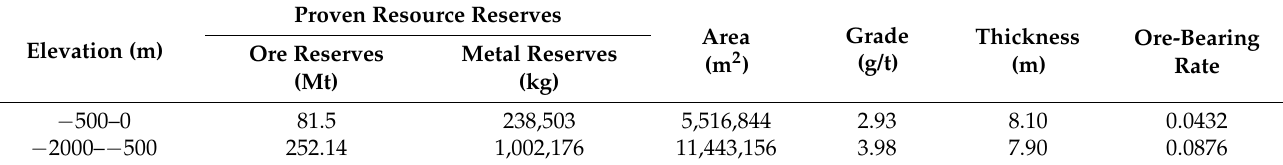
Table 6. Ore-hosting rates of the Sanshandao fault.